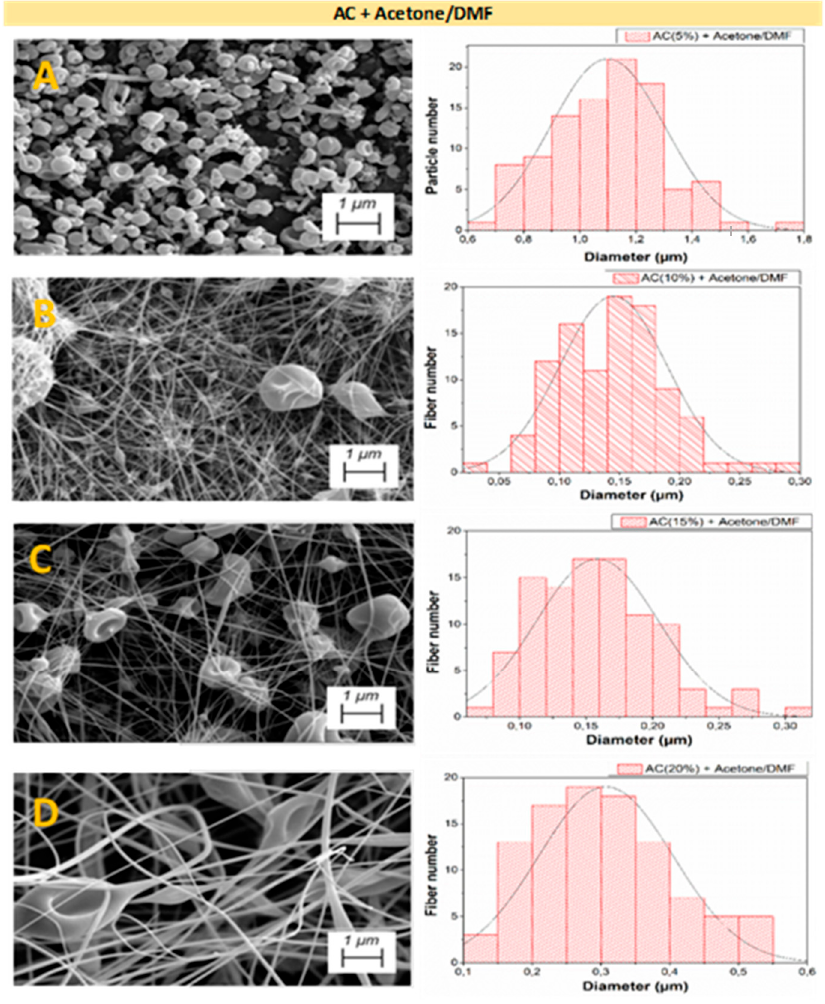
Figure 4. SEM images and distribution of microstructural properties of the nanostructures made with different AC concentrations: ( A ) 5 wt.%, ( B ) 10 wt.%, ( C ) 15 wt.%, and ( D ) 20 wt.%, using acetone and DMF as solvents.